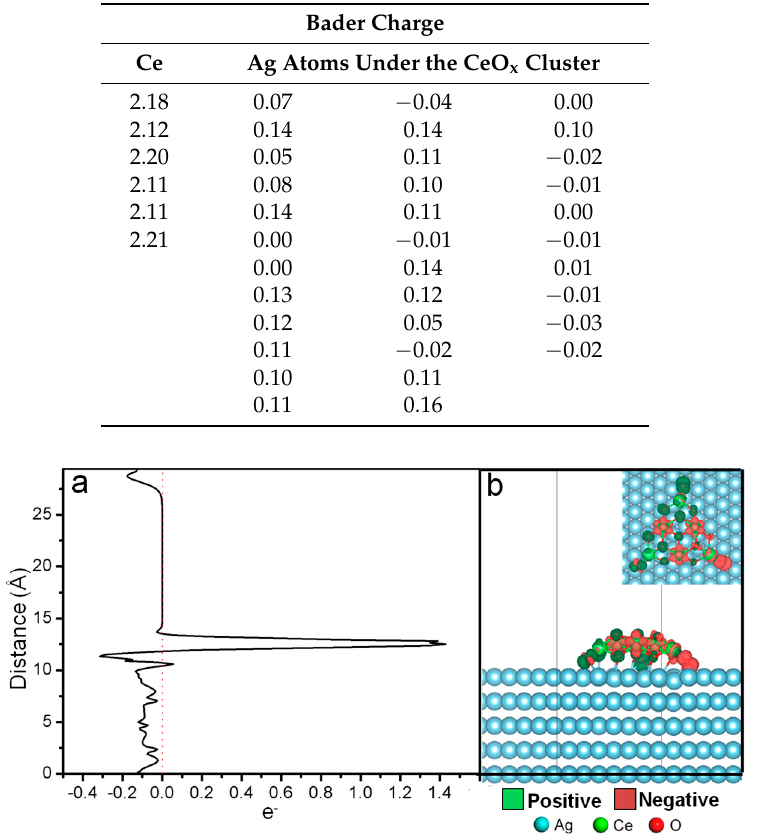
Figure 1. Spin density difference (SDD) of the CeO x /Ag(111). ( a ) Spin Density Difference (SDD) versus Z direction of the CeO x /Ag(111) catalyst, ( b ) Isosurfaces for single electron distribution.